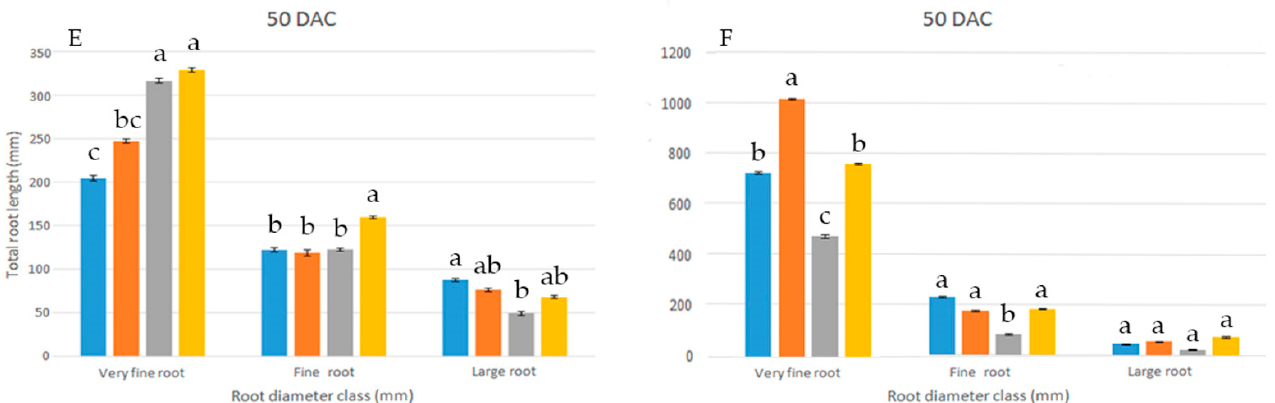
Figure 3. Total root length distribution (%) of wild sage ( A , C , E ) and glossy abelia ( B , D , F ) in three diameter classes, evaluated at three sampling dates, as effect of four IBA concentration. Vertical bars with different letters means significant differences according with S.N.K. test, p ≤ 0.05 for each class root diameter. Data shown are means ± SE of three replicates.